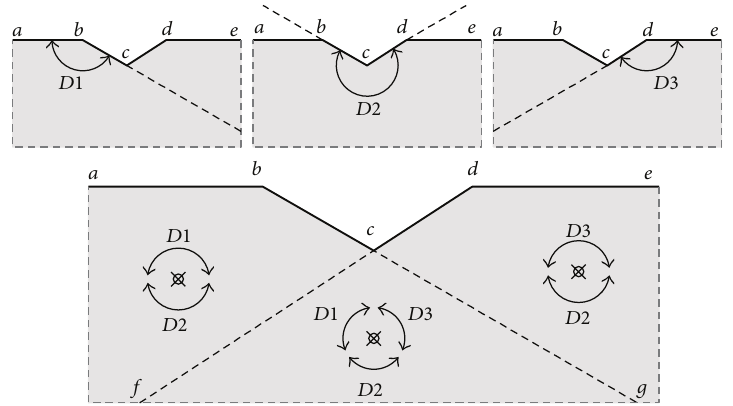
Figure 6: Partition of the domain to compute the diffracted field. Each wedge contributes with a source of diffraction producing waves over a given part of the domain (top). Zones where the contribution from several wedges overlaps are indicated by the curved rays.